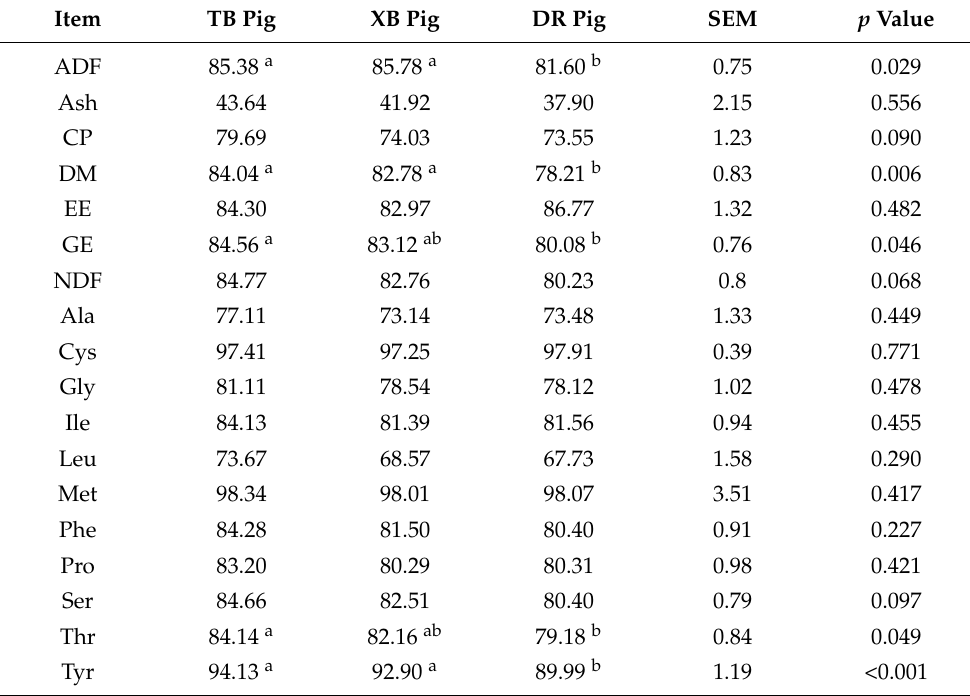
Table 12. Apparent total tract digestibility of three pig breeds at 80 days of age